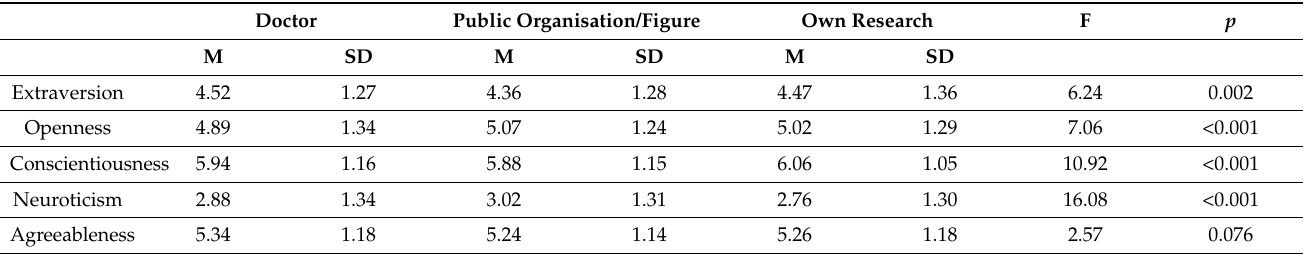
Table 4. Relationship between influence of personal or professional endorsement of COVID-19 vaccination and Big Five personality traits.